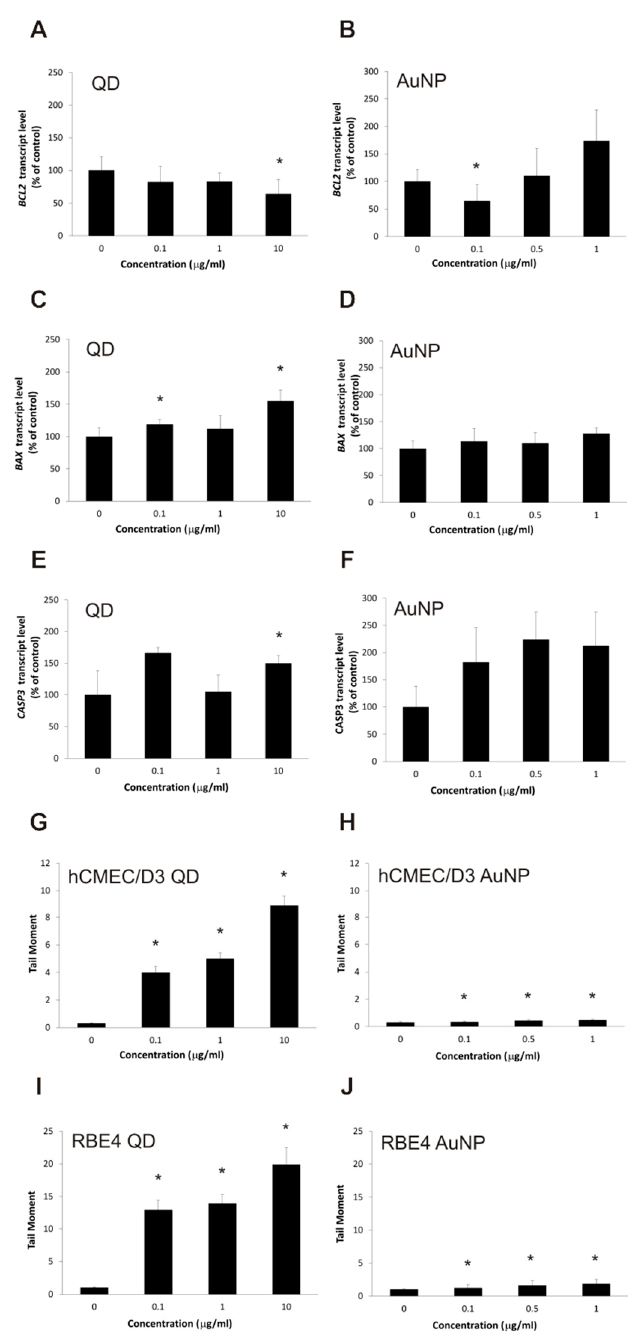
Figure 5. Apoptosis hallmarks in brain microvascular endothelial cell lines exposed to nanoparticles. Expression of apoptosis-related proteins in the hCMEC/D3 cell line, treated with QD (panels ( A , C , E )) and AuNP (panels ( B , D , F )) nanoparticles, was assayed by real-time RT-PCR for cognate mRNAs (encoding Bcl-2—panels ( A , B ); BAX—panels ( C , D ); and caspase 3—panels ( E , F )), calculated as relative copy number values per housekeeping gene index and presented as average ± S.D. ( n = 6 in panels ( C , D ); n = 8 in panels ( A , B , E , F )). Asterisks indicate differences from control (untreated cells) which were statistically significant at p < 0.05. Nuclear DNA fragmentation in hCMEC/D3 (panels ( G , H )) and RBE4 (panels ( I , J )) cell lines, treated with QD (panels ( G , I )) and AuNP (panels H , J ) nanoparticles, was assayed by the alkaline comet method, calculated as the comet tail moment and presented as the average ± S.D. ( n = 100). Asterisks indicate differences from control (untreated cells) which were statistically significant at p < 0.05.